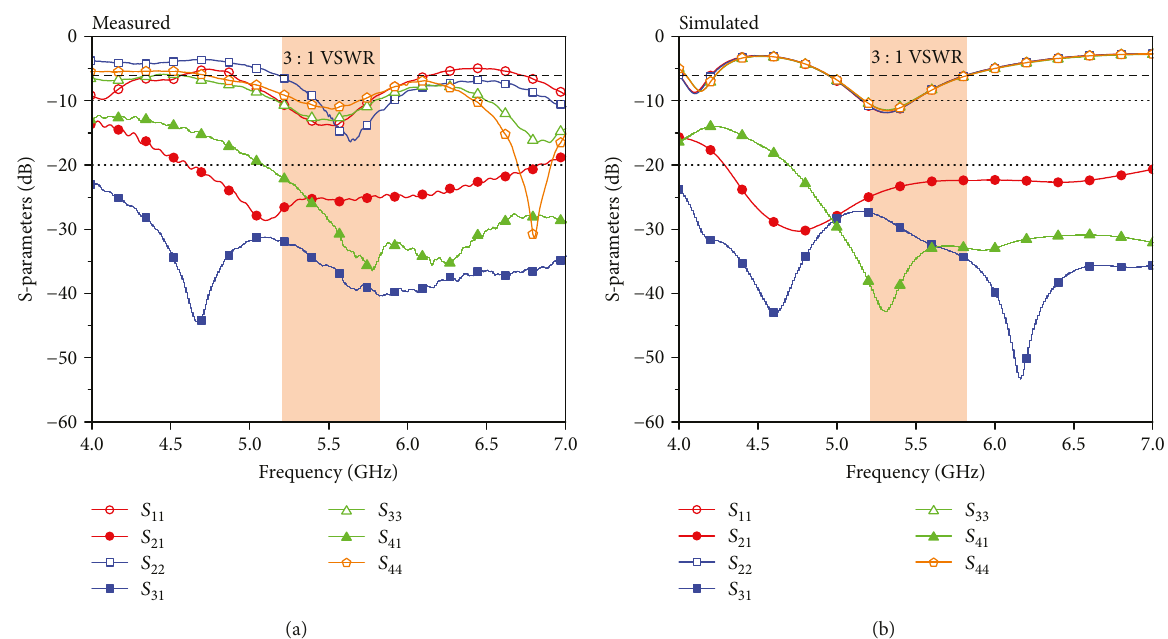
Figure 12: (a) Measured S-parameters for the four-element MIMO antennas with a human wrist and (b) simulated ones with the wrist model.